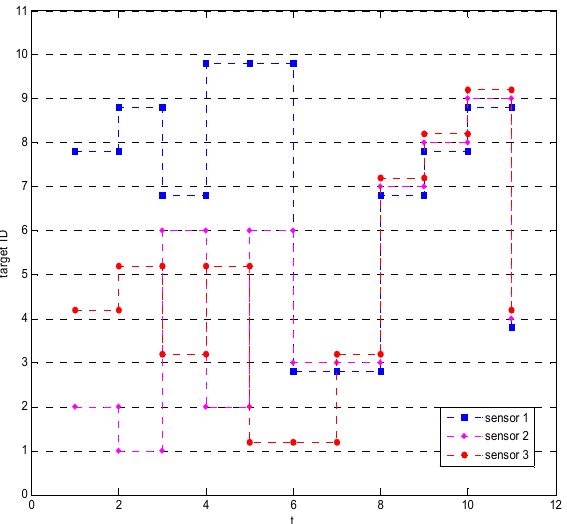
Figure 5. Sensor assignment results for the proposed method in scenario 3.